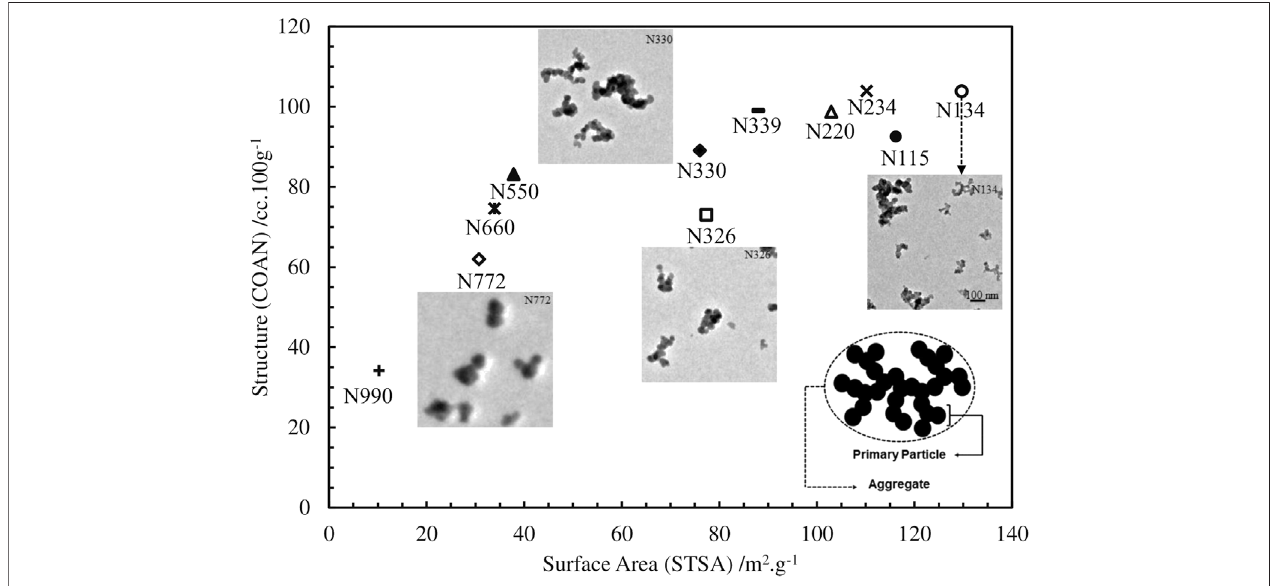
FIGURE2| Colloidalplot ofcarbon blacksstudied in thisarticle. Ameasure ofthe structure (COAN) isplotted againstameasure ofthesurface area(STSA).Insert: Schematic of the primary particle-aggregate hierarchical structure of carbon black and representative TEM images of N772, N326, N330 and N134.